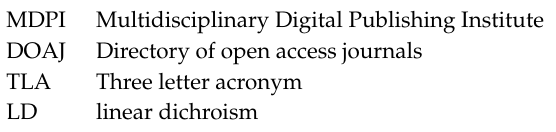
Supplemental Figure S1: 1H 1D NMR spectra of the aromatic region of Hst5 under different conditions and variants. Supplemental Figure S2: Kratky plots visualising the difference in shape between Hst5 in the absence and presence of zinc. Supplemental Figure S3: The effect of zinc on the shape of Histatin 5 and selected variants. Supplemental Figure S4: Fits calculated from the DAMMIF scattering envelope shown for each measured sample. Supplemental Figure S5: Representative diffusion data measured on Wt Hst5 A) with and B) without Zn2+ added. Supplemental Figure S6: Experimental Rg/Rh ratio compared with theoretical Rg/Rh ratio for the Hst5